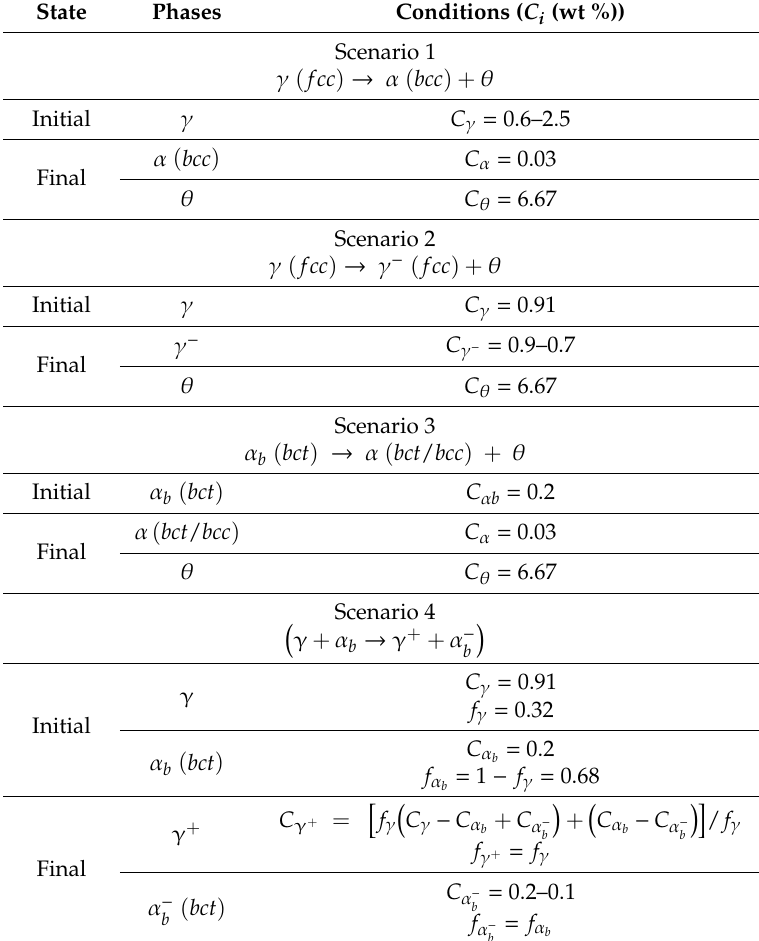
Table 5. Conditions used to calculate by atomic volumes the relative change in length (RCL) and the fraction of the phases involved in the mentioned scenarios occurring during a tempering treatment. The signs – and + denotes more or less C as compared to the initial state,